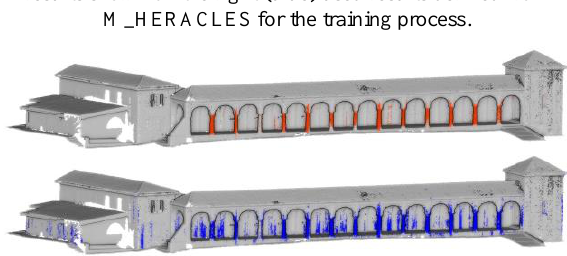
Figure 5. Predicted scenes of the first scenario on Kasepuhan_1. On the left side (red) the semantically segmented column class from the training using manually labelled data is shown. The results shown on the right (blue) used results derived from M_HERACLES for the training process.